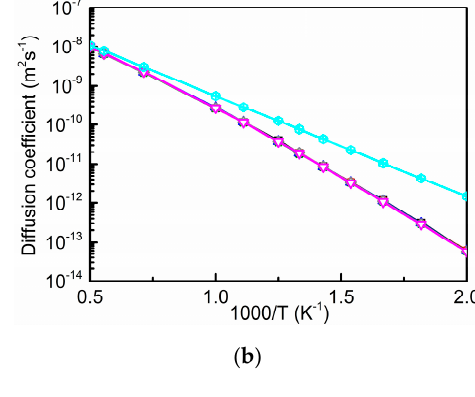
D ) and outside ( D ) the interaction region inter free c (in at.%) of these substitutional solutes. S